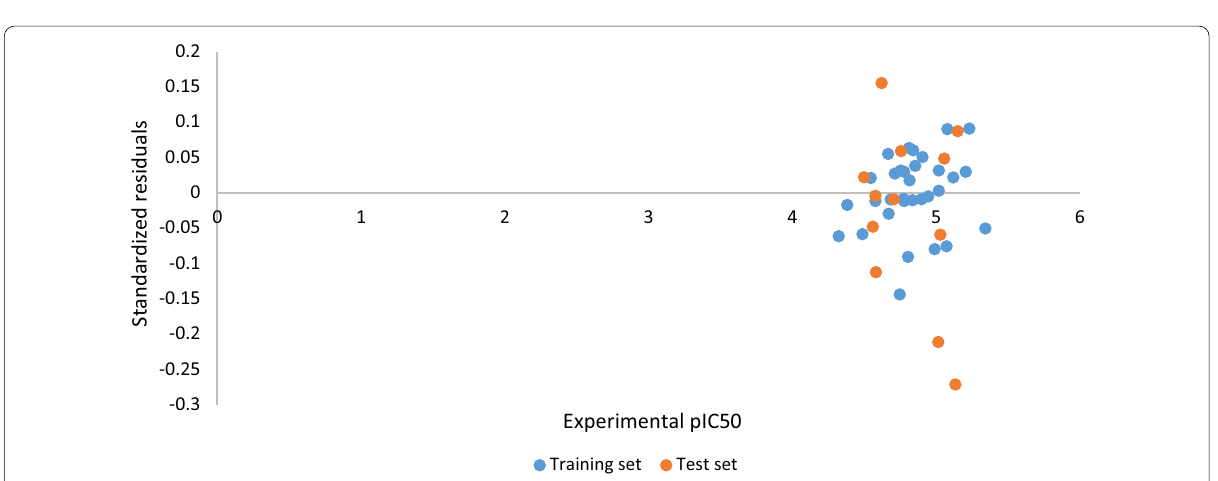
Fig. 3 Plot of standardized residuals against the experimental activities of the training and test